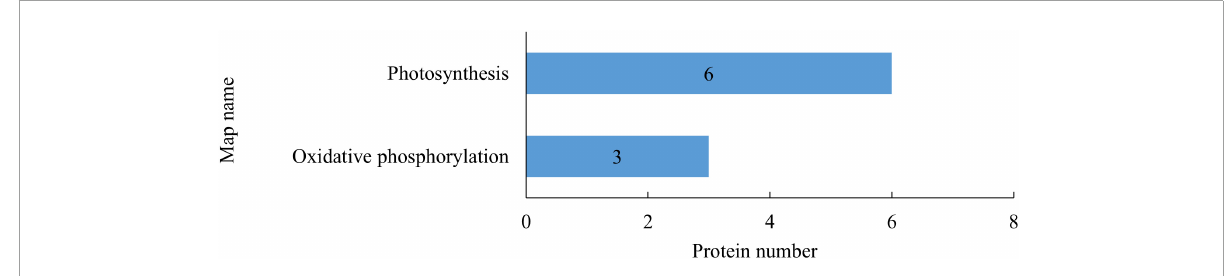
FIGURE3 Kyoto Encyclopedia of Genes and Genomes (KEGG) pathways of differentially expressed proteins (DEPs) in rice leaves after straw return. The abscissa indicates the number of DEPs involved in the pathways, and the ordinate indicates the pathways in which the differentially expressed metabolites (DEMs) are